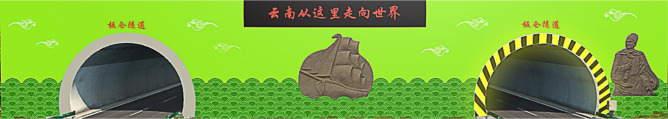
Decorative model of the portal completed in Blender (the slogan means: Yunnan is approaching the world).